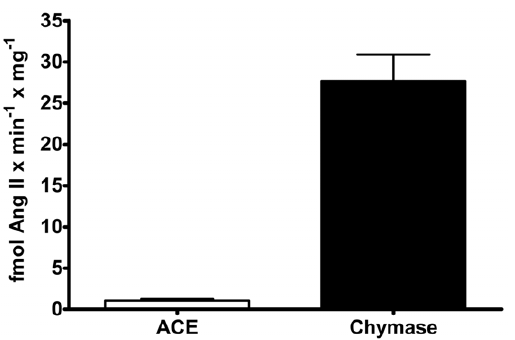
Figure 3. Chymase and ACE contribution to generate Ang II from Ang-(1-12). Chymase and ACE enzyme mediated generation of Ang II product from the metabolism of 125 I-Ang-(1-12) (1 nmol/L) by plasma membrane isolated from human atrial tissues. The contribution of each enzyme (chymase, and ACE) activity (fmol Ang II formation 6 min 2 1 6 mg 2 1 ) were calculated based on Ang II product analysis by HPLC in each human samples incubated with or without the chymostatin and lisinopril (each added at a dose 50 m M) for 60 min at 37 u C. Data are expressed as mean 6 SEM; total n=9 (4 female).